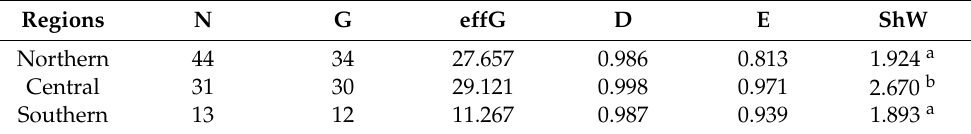
Table 1. Clonal diversity indexes calculated for Ilex guayusa in the three Ecuadorian Amazon regions. Regions N G effG D E ShW Northern Central